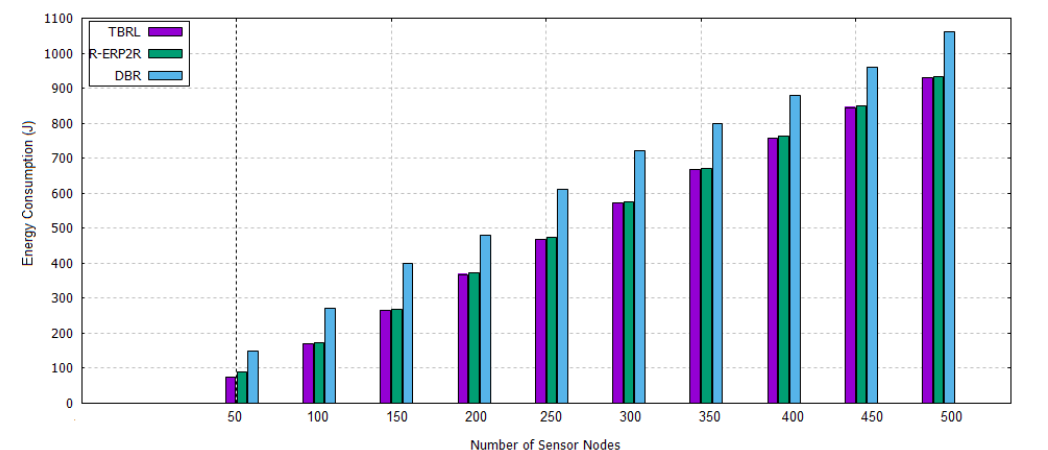
Figure 15. Energy Consumption of TBRL, DBR and R-ER P 2